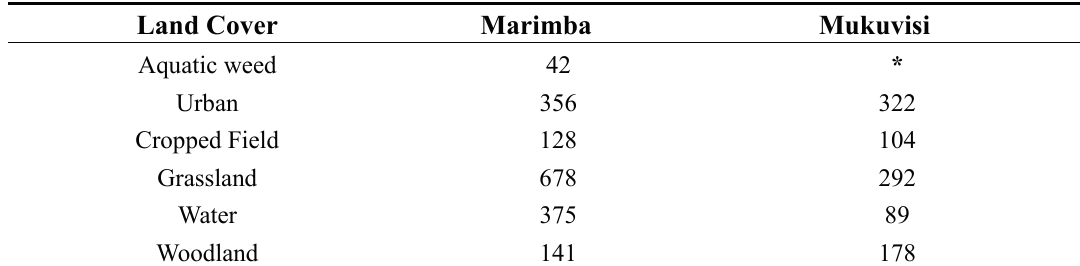
Table 4. Average number of points used for validating the classified landcover images for Marimba and Mukuvisi